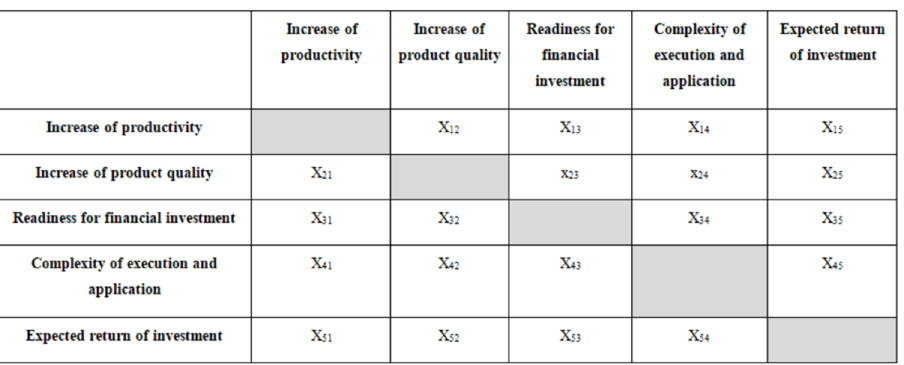
Figure 3. Structure of the implementation model for Industry 4.0 elements oriented to process plan- ning. The mathematical procedure where the input data are the goal and element weights with output data as ranks of elements is shown in (1). (1) where: a ij —weights of return of investment time b ij —weights of product quality increase